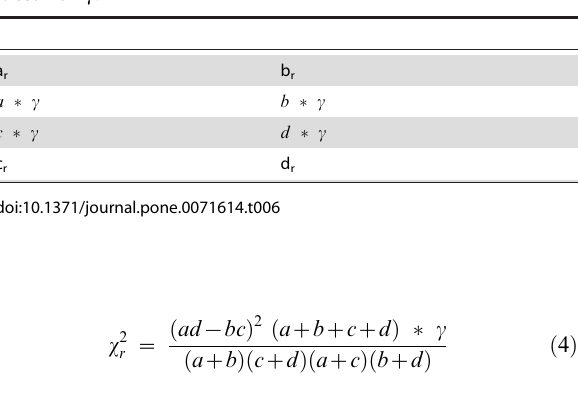
Table 6. 2 6 2 contingency table for samples increased by a factor of c